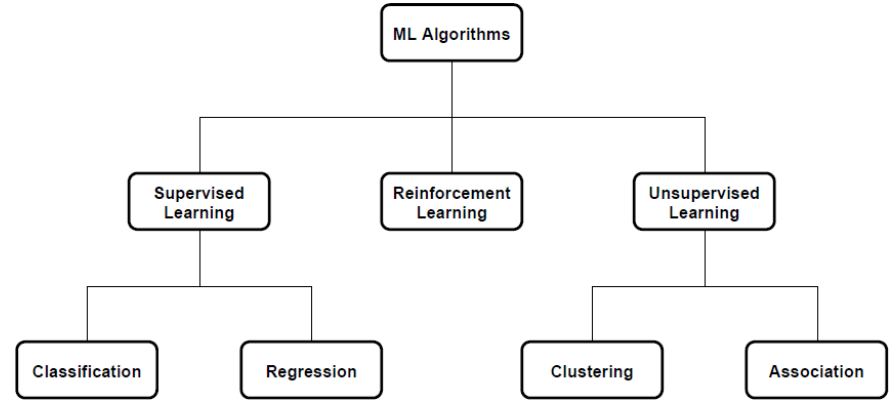
Figure A1. General classification scheme for different machine learning approaches.